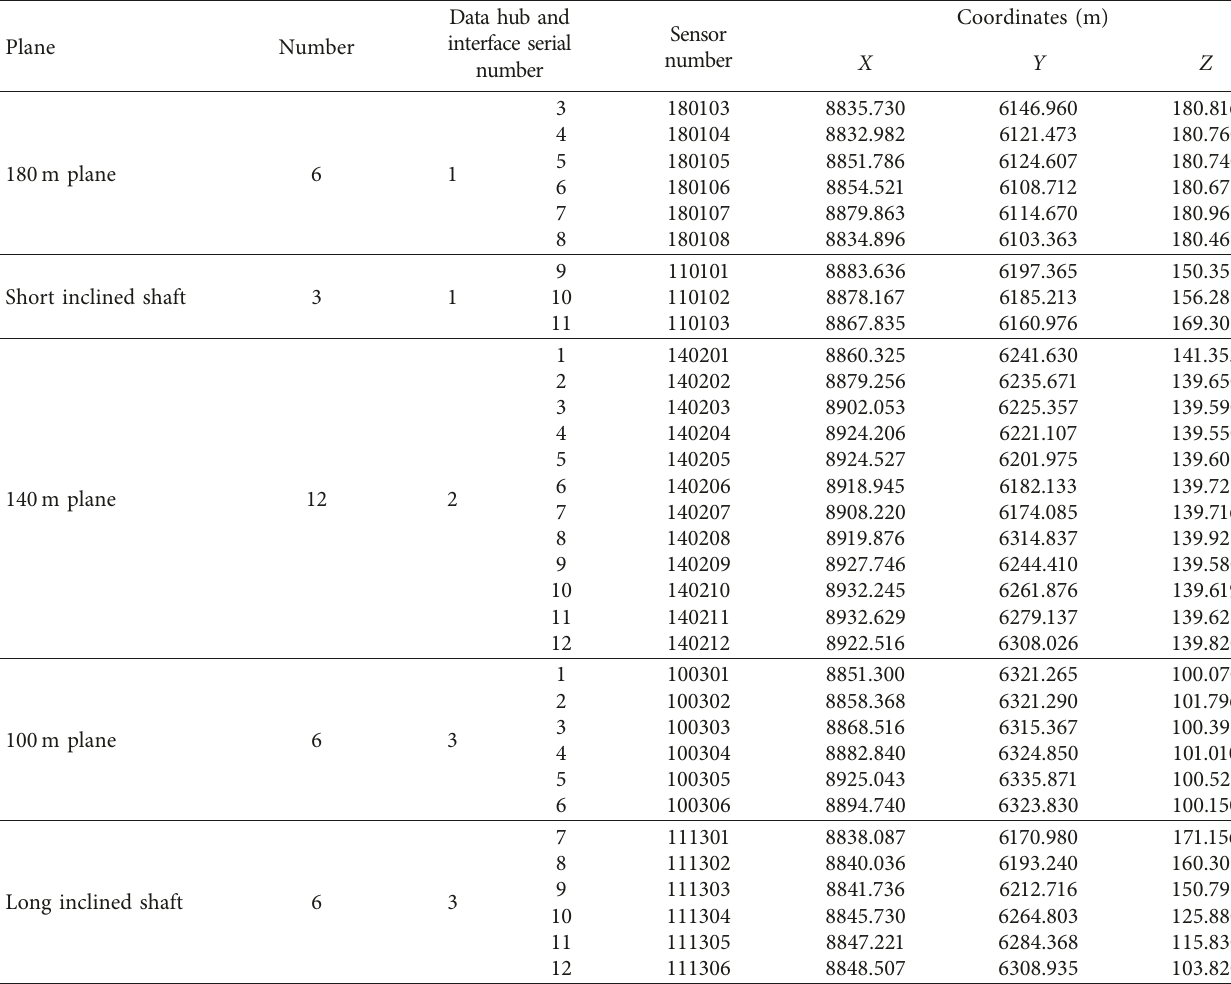
Table 1: Sensor location